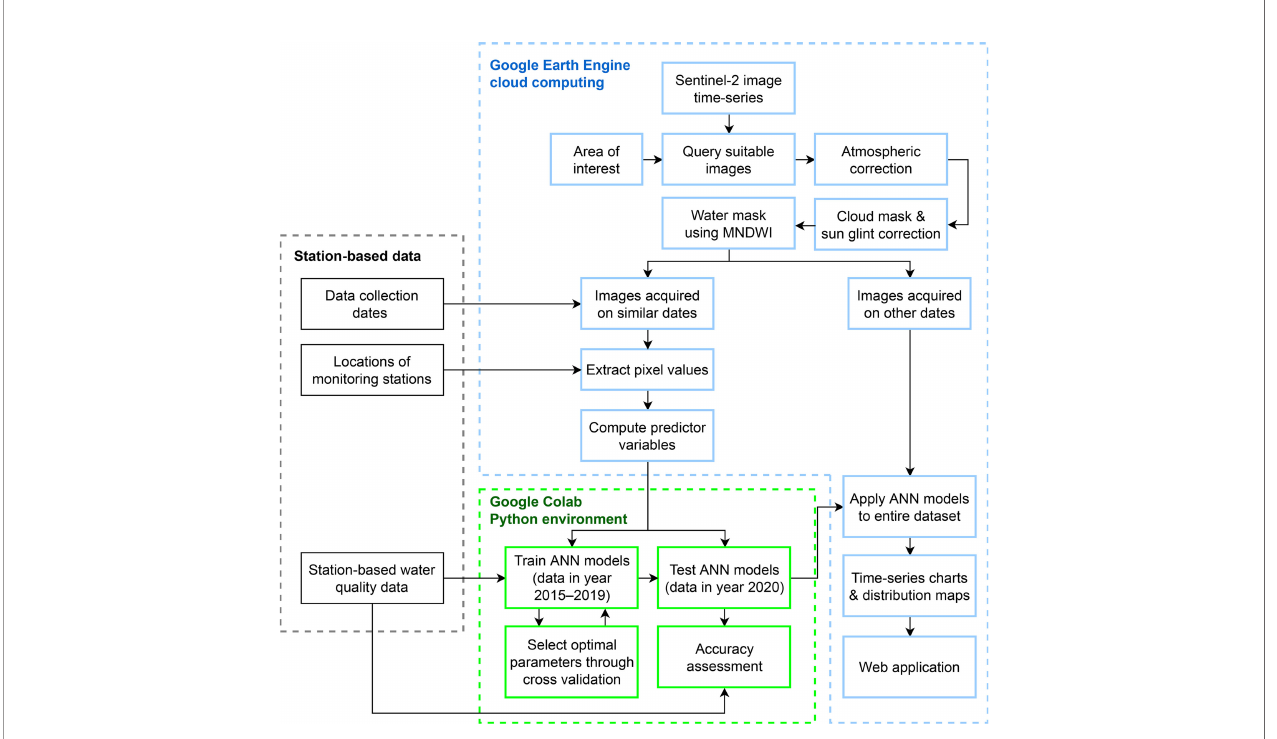
FIGURE 2 | Flowchart of the proposed framework to estimate water quality parameters using Google Earth Engine (GEE) cloud computing platform and arti fi cial neural network (ANN) algorithm. (MNDWI, Modi fi ed Normalized Difference Water Index).